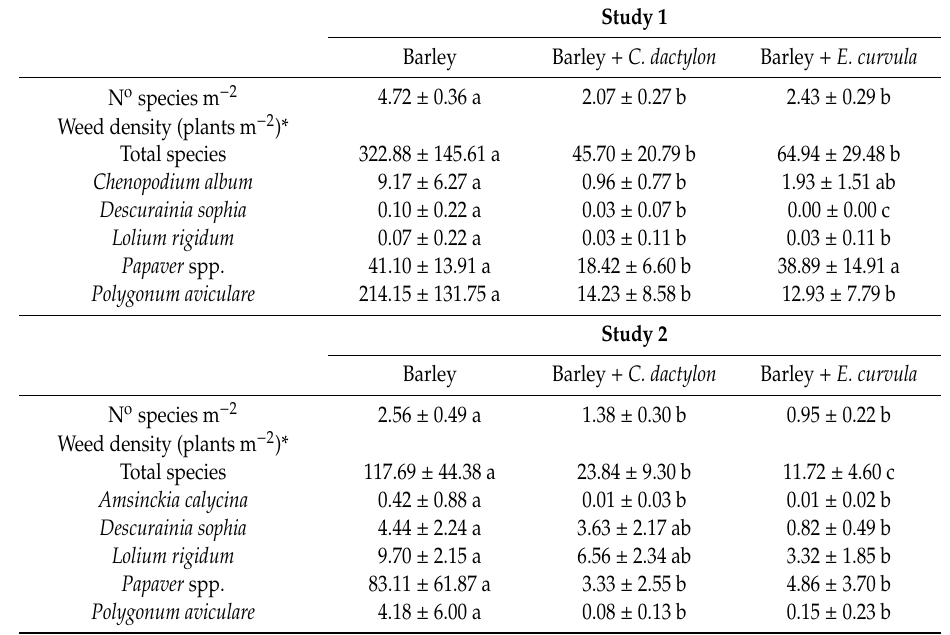
Table 4. Weed establishment and species (Number and density) in the three treatments in Studies 1 and